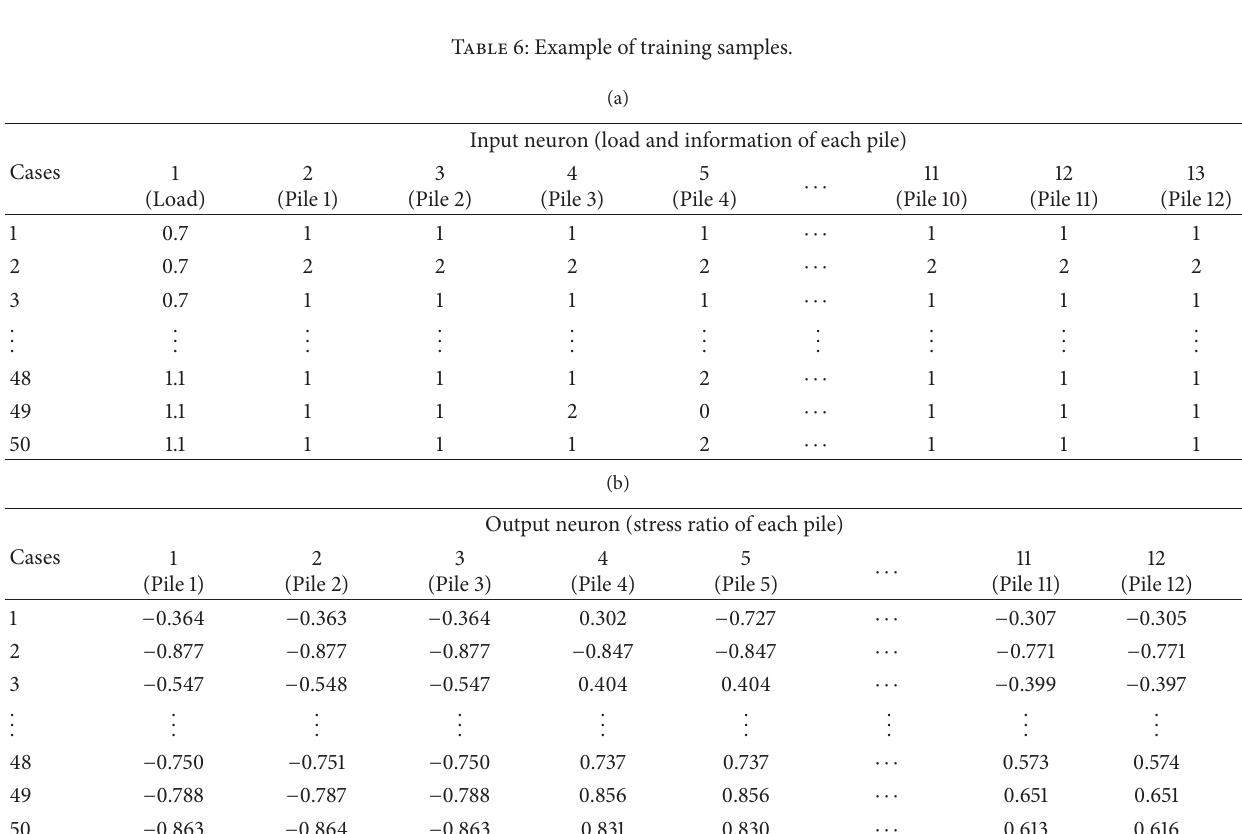
Figure 6: Maximum stress ratio of each pile.